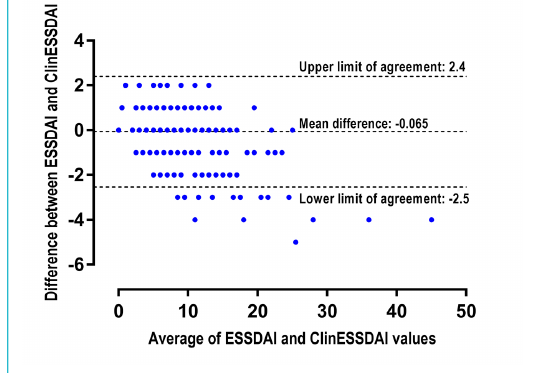
Figure 3: Differences between ESSDAI and ClinESSDAI plotted against their averages (n = 665).ClinESSDAI = Clinical EULAR